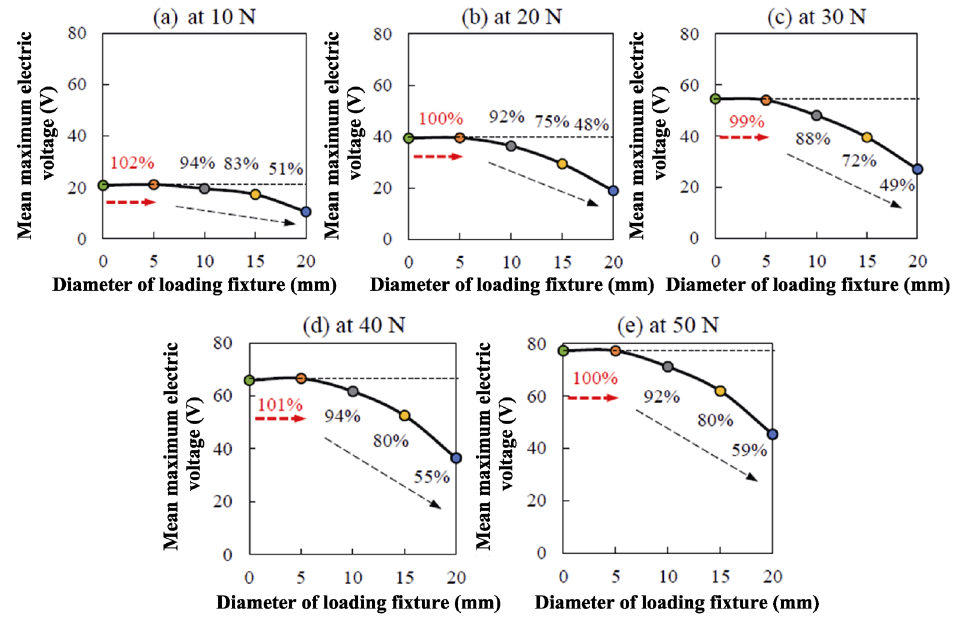
Fig. 5 Mean maximum voltage as a function of loading fixture diameter for various loading values.